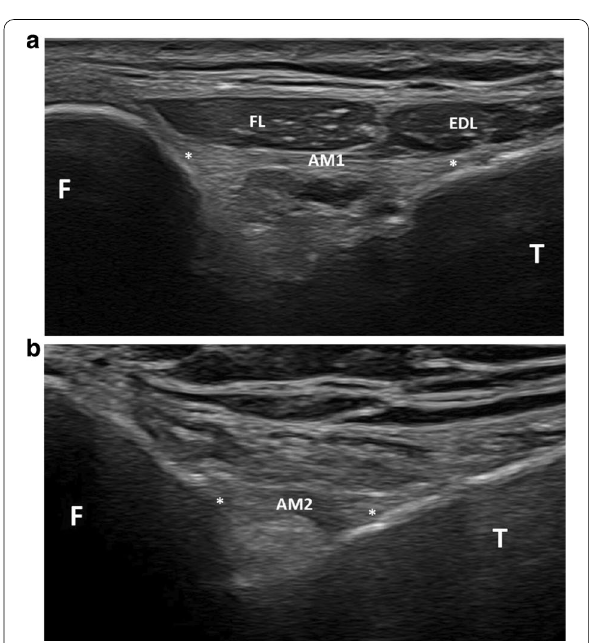
Fig. 5 Middle bundles of the anterior PTF joint. a Transverse plane showing the upper middle bundle (AM1 and stars), which courses from the anterosuperior aspect of the lateral edge of the fibular head (F) to the lateral aspect of the tibia (T). FL: fibularis longus muscle; EDL: extensor digitorum longus muscle. b Slightly upwards and forwards oblique transverse plane showing the lower middle bundle (AM2 and stars) extending from the anterior aspect of the fibular head (F) to the lateral edge of the tibia (T)